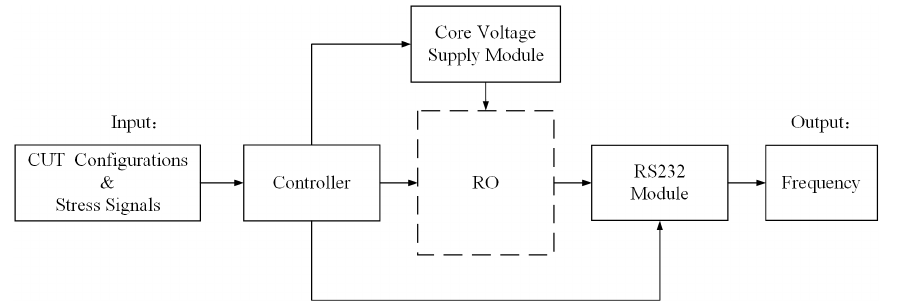
Figure 2. Logic function module of the aging